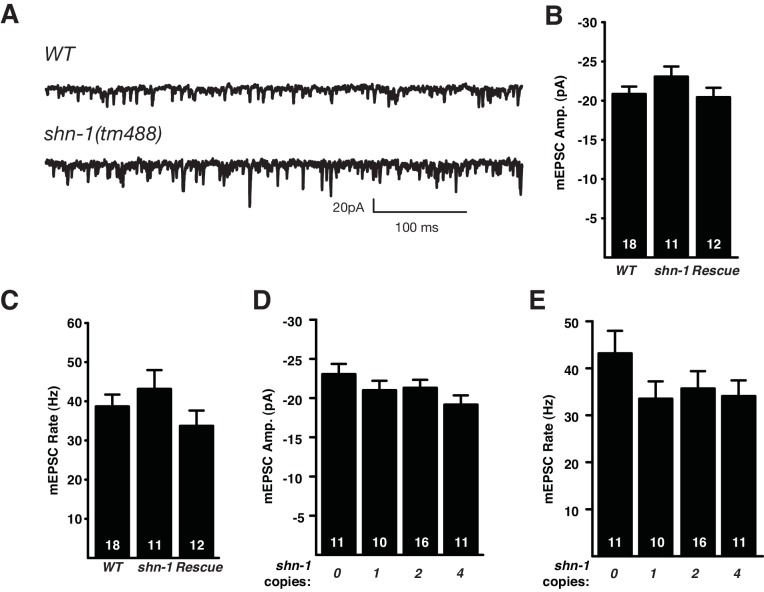
shn-1 mutations and gene dosage had no effect on mEPSCs.mEPSCs were recorded from adult body muscles of the indicated genotypes. Representative traces (A), mean amplitude (B,D), and mean rate (C,E) are shown. No significant differences were observed. The number of animals analyzed is indicated for each genotype. Error bars indicate SEM. Mean, standard errors, sample sizes, and p values for this figure are shown in Supplementary file 1.